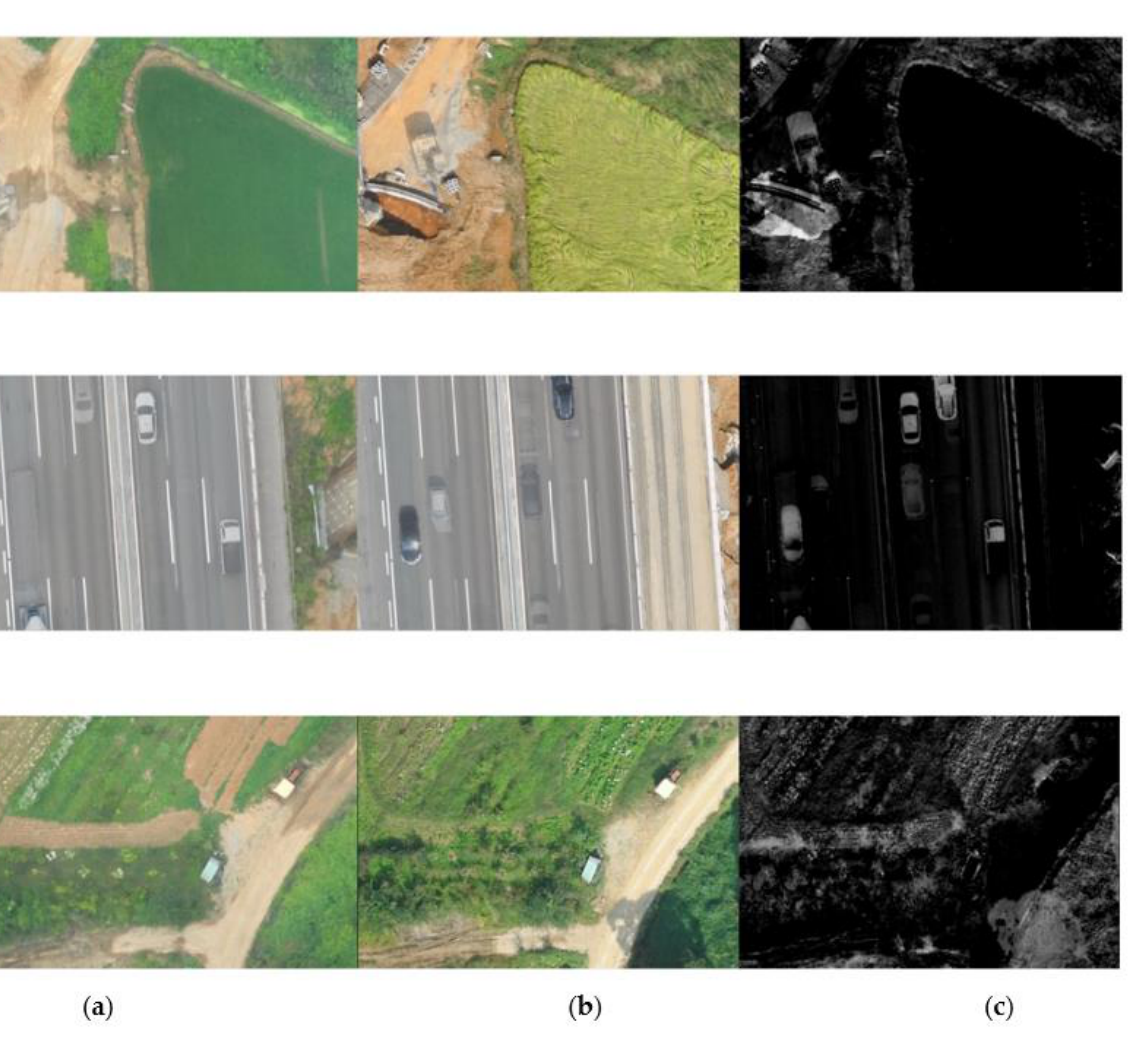
Figure 6. Results obtained using the image difference method; ( a ) and ( b ) display bitemporal images. ( c ) Result obtained using the image difference method.